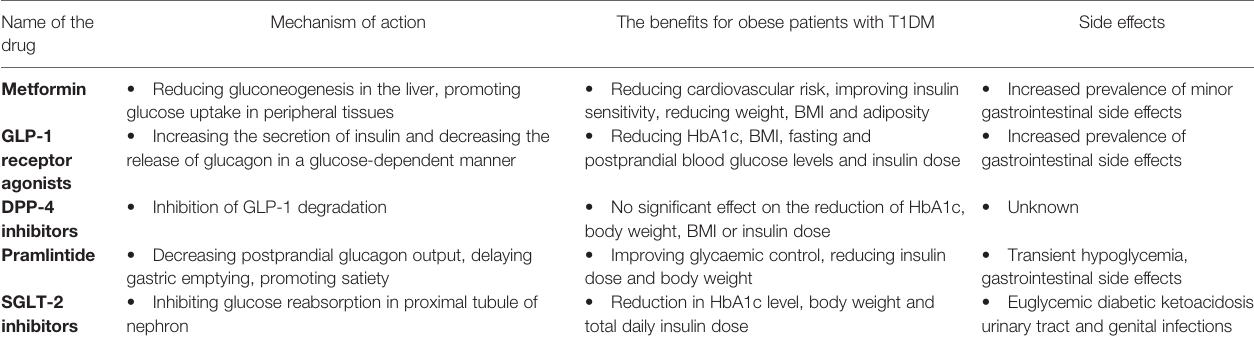
TABLE 4 | A review of potential adjuvant pharmacological therapies to insulin in obese patients with type 1 diabetes. Name of the drug